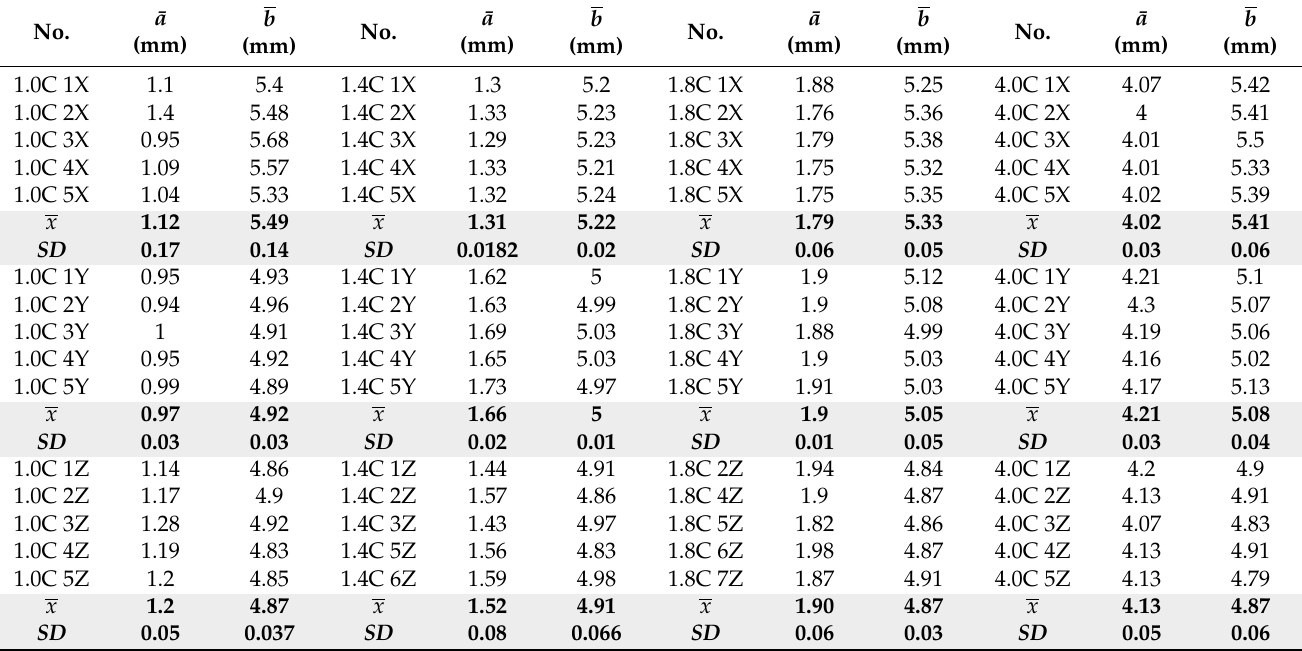
Table 3. Dimensions of the PLA-CF prints before the tensile